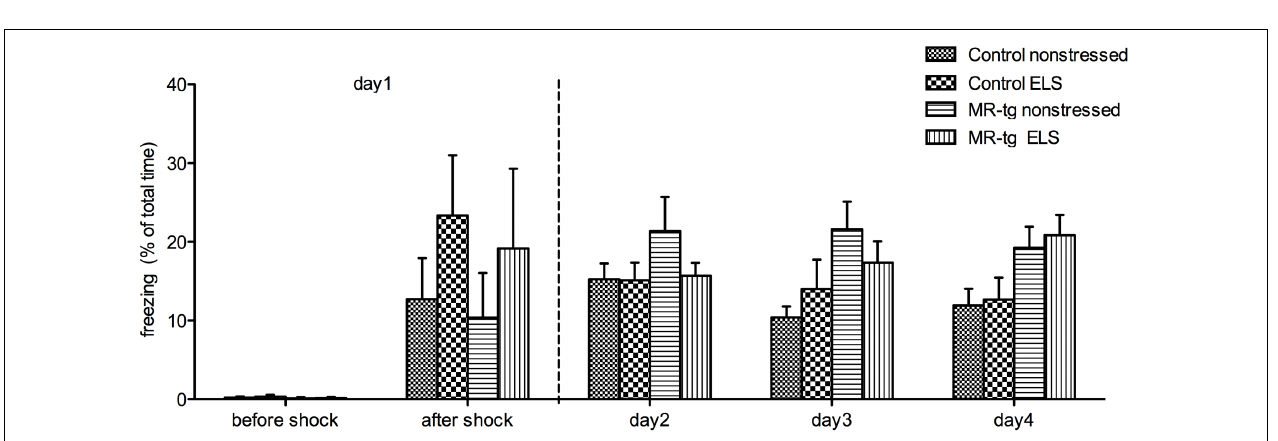
FIGURE 3 | Open field behavior in MR-tg and control mice. Bar graphs represent the results for (A) locomotion and (B) ‘anxiety-like behavior’ as measured by the total time mice spent in the central zone in the open field. Data are expressed as mean ± SEM. n = 10–12 mice per group.